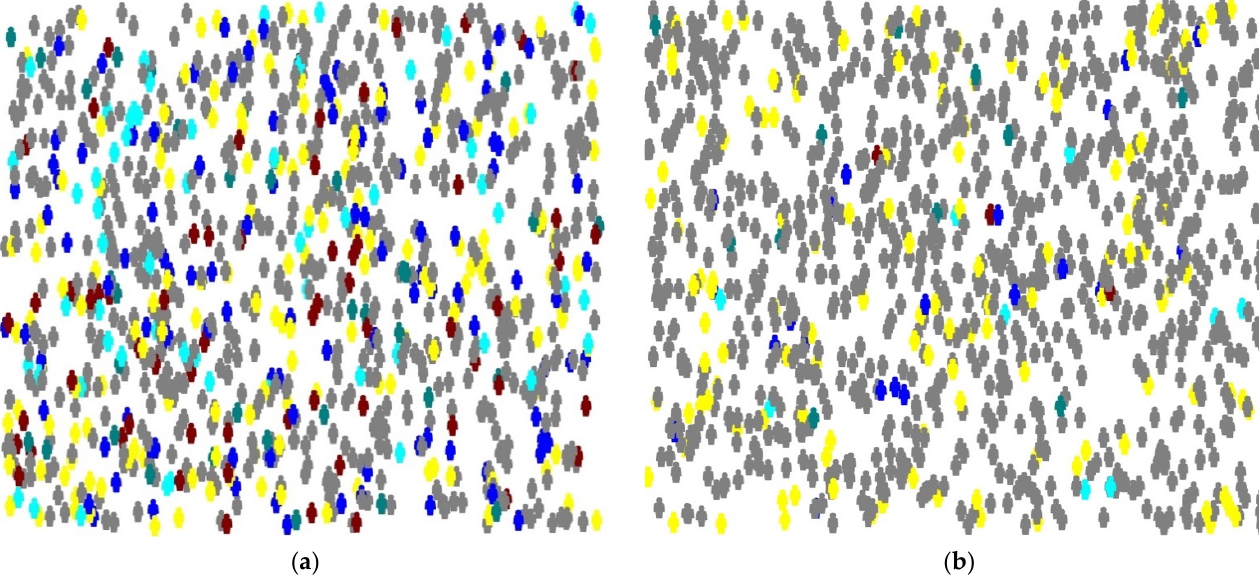
Figure 6. ( a ) Predictive model’s population of 1000 agents over a 6-month period. Day 20. ( b ) Reductive’s model population of 1000 agents over a 6-month period. Day 170.